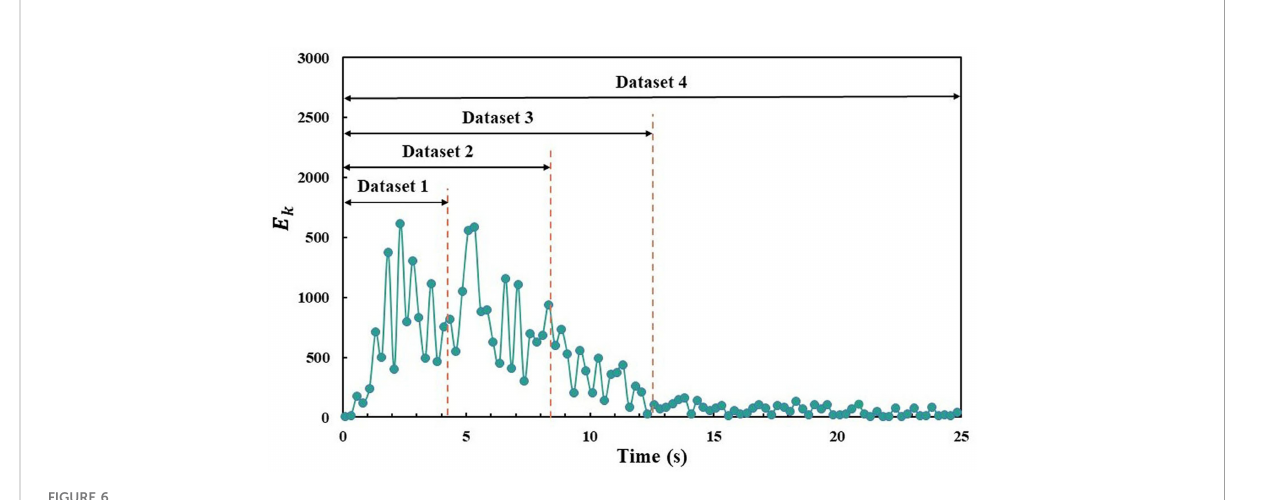
FIGURE 6 The illustration of dataset